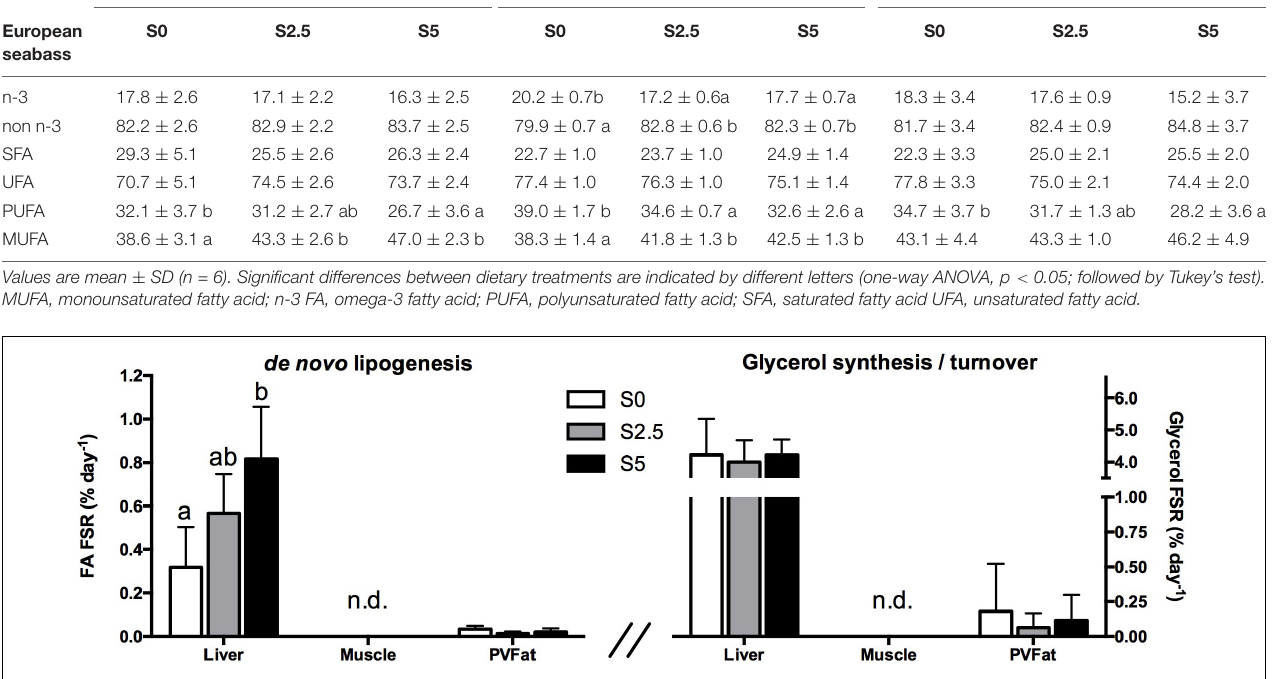
TABLE 4 | Percentage of fatty acid classes as determined from 1 H NMR spectra of TAG from liver, muscle and perivisceral fat of European seabass ( Dicentrarchus labrax ) fed with different levels of glycerol (0, 2.5, and 5%). Liver Muscle Perivisceral fat European seabass